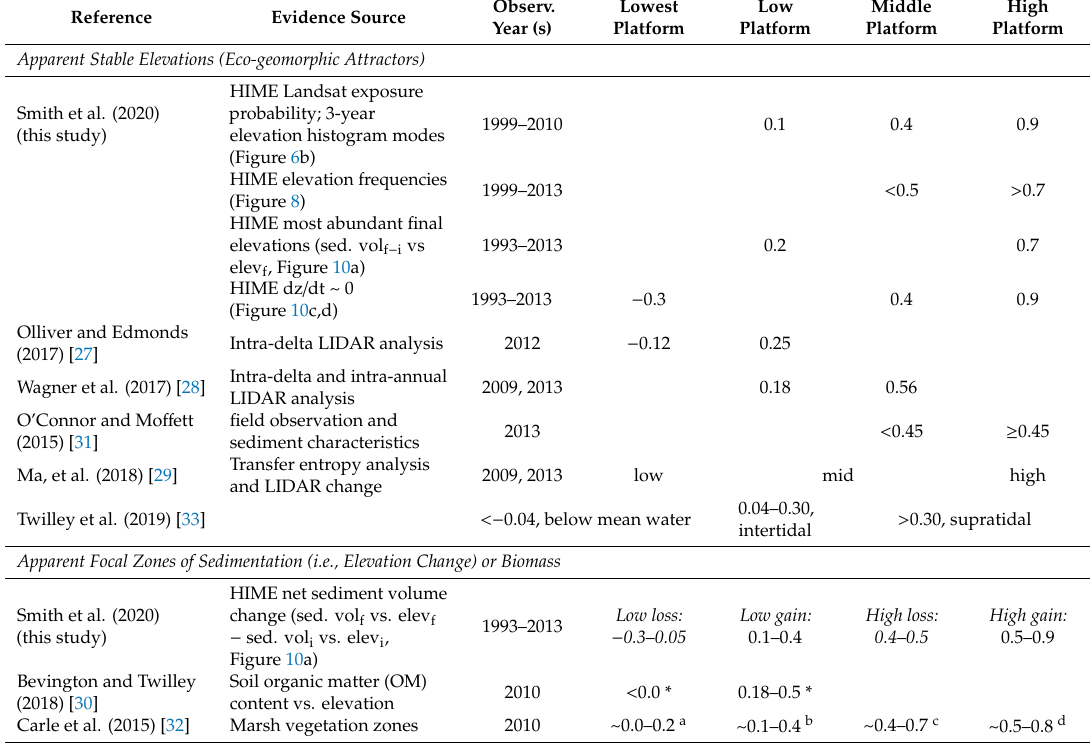
Table 2. Comparison of the multiple stable states of marsh elevations (stable platforms), vegetation, and water levels at the WLD by this study and others. Elevations in meters above